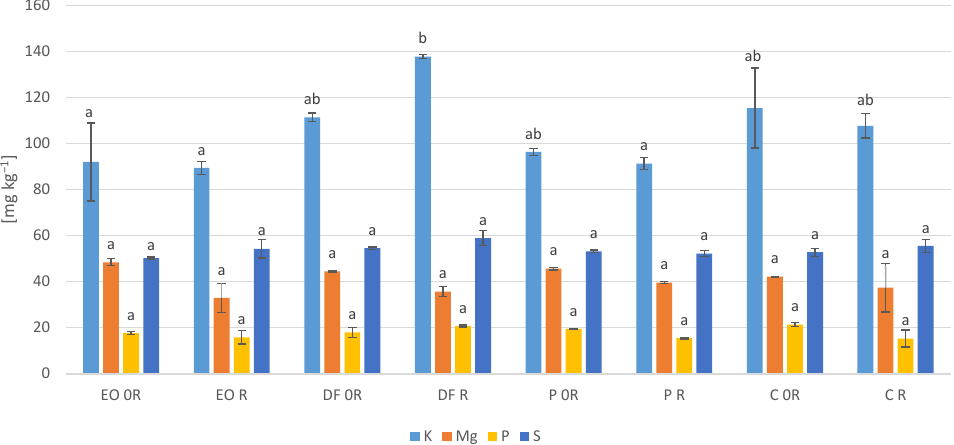
Figure 2. The effect of PDSs and bioremediation on the content of potassium, magnesium, phosphorus and sulfur in the experimental soil (potentially bioavailable elements). The means (± SE) for individual elements that are marked with the same letters did not differ significantly according to Tukey’s test at p < 0.05. The symbols are the same as those in Table 3.